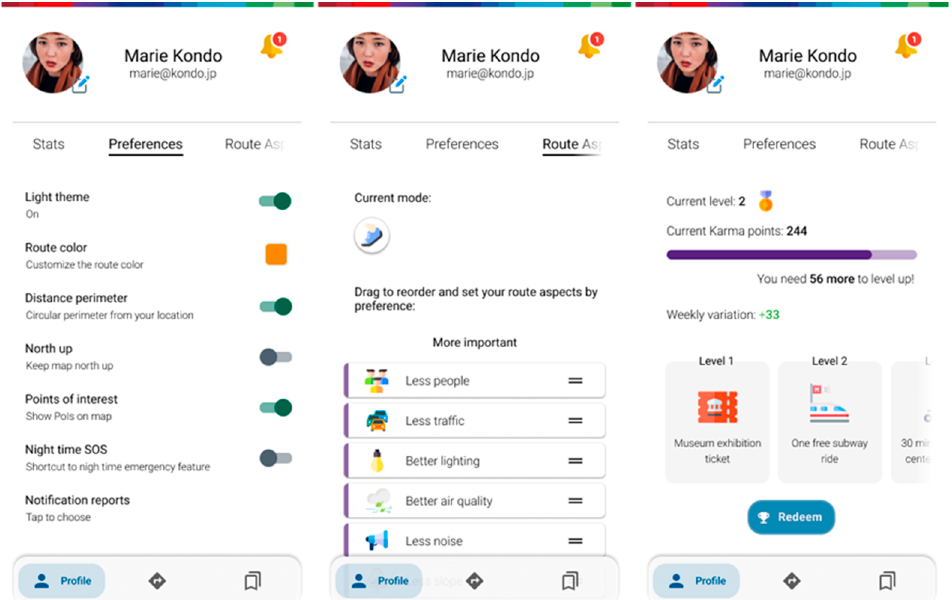
Figure 10. Screens of the profile section featuring user preferences, ordering route aspect importance, and a rewards section.